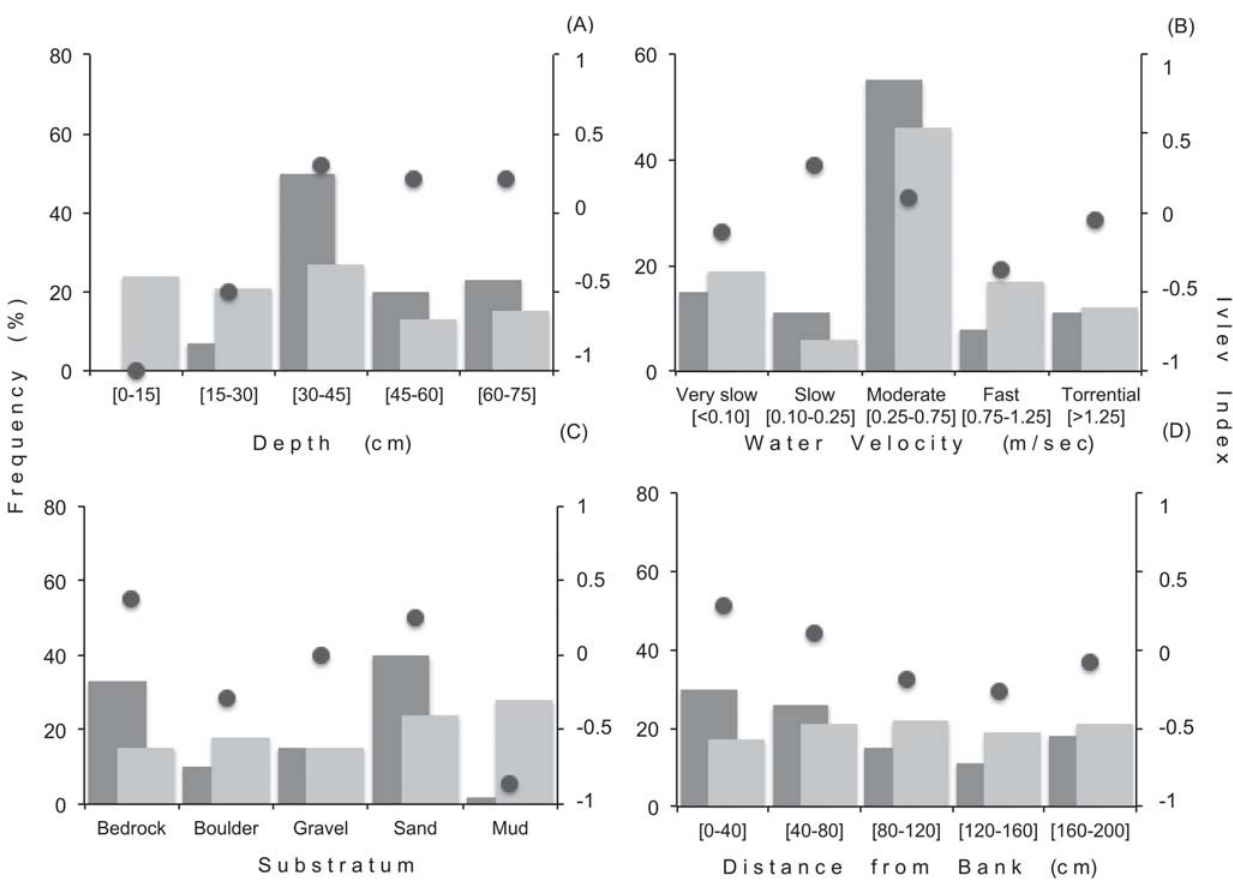
Fig. 1. Availability (light grey bars), use (dark grey bars), and Ivlev Index (black circles) for the four studied microhabitat parameters affecting Astyanax taeniatus from Roncador stream: (A) total depth; (B) focal water velocity; (C) substratum; (D) distance from the nearest